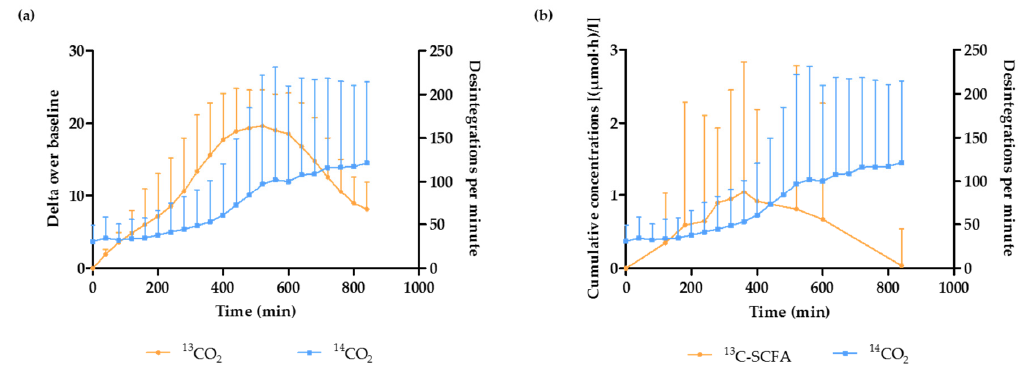
Figure 4. Both 13 C-excretion in breath ( a ) and plasma 13 C-SCFA concentrations ( b ) start to increase Figure 4. Both 13 C ‐ excretion in breath ( a ) and plasma 13 C ‐ SCFA concentrations ( b ) start to increase before the increase in breath 14 CO 2 ( n = before the increase in breath 14 CO 2 ( n = 40).